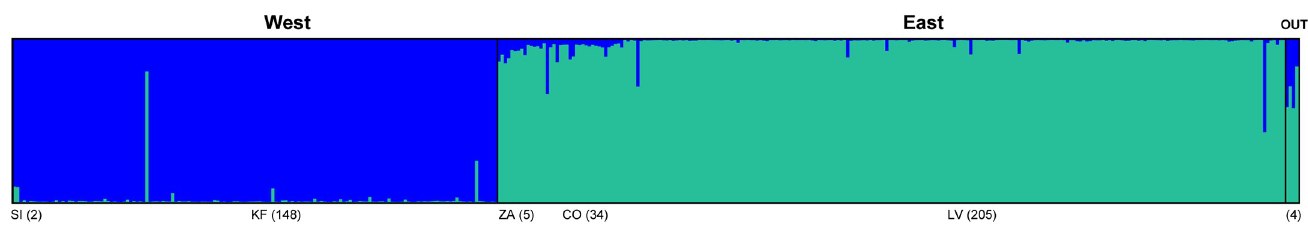
Fig 3. Results of STRUCTURE analysis based on 14 microsatellite loci of 398 Zambian lions. Population assignment results for Δ K = 2 showing a separation of the western and eastern lion populations in